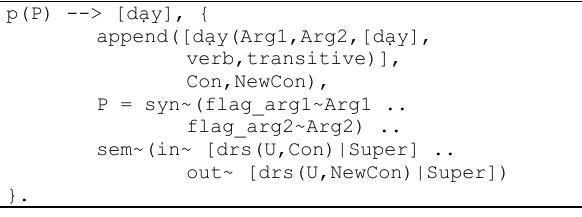
Figure 11. Describe transitive verb “dạy” (example 5) in the first three groups based on framework GULP